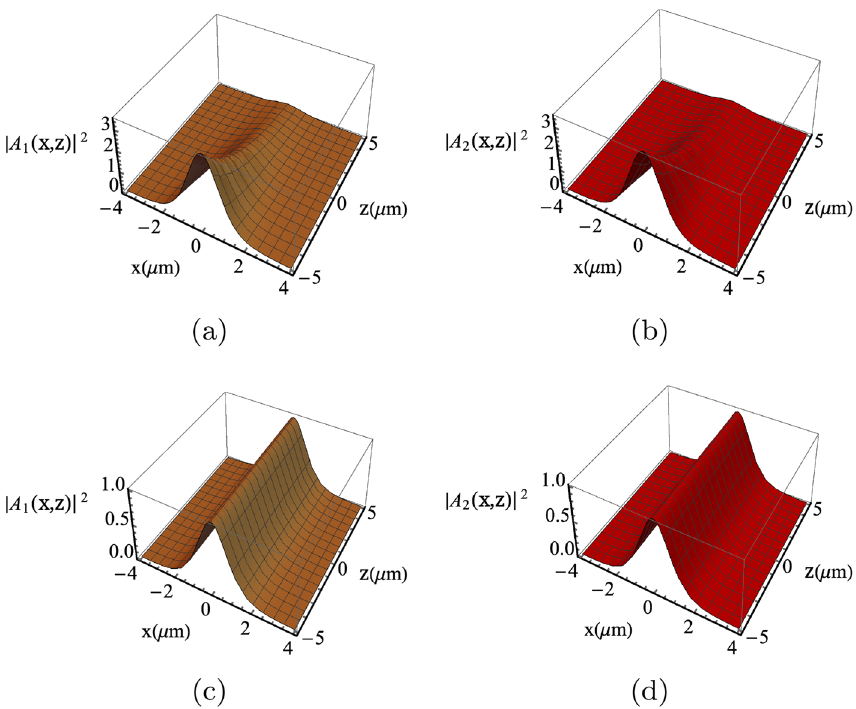
90 GHz . In ( a , b ) the solitons profile are =